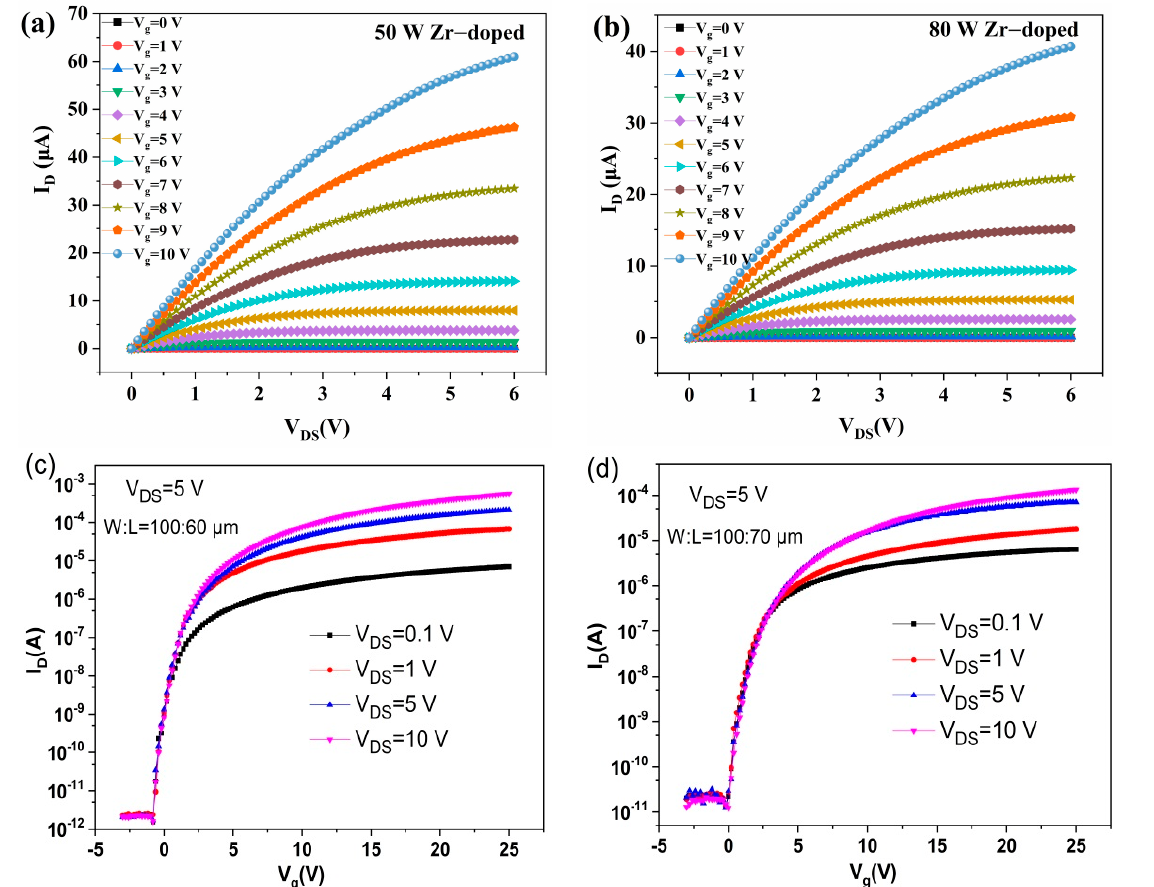
Figure 7. Output and transfer curves of SHZS-based a-IGZO TFT. ( a ) Output curves, Zr-doping power is 50 W; ( b ) output curves, Zr-doping power is 80 W; ( c ) transfer curves, Zr-doping power is 50 W; ( d ) transfer curves, Zr-doping power is 80 W.